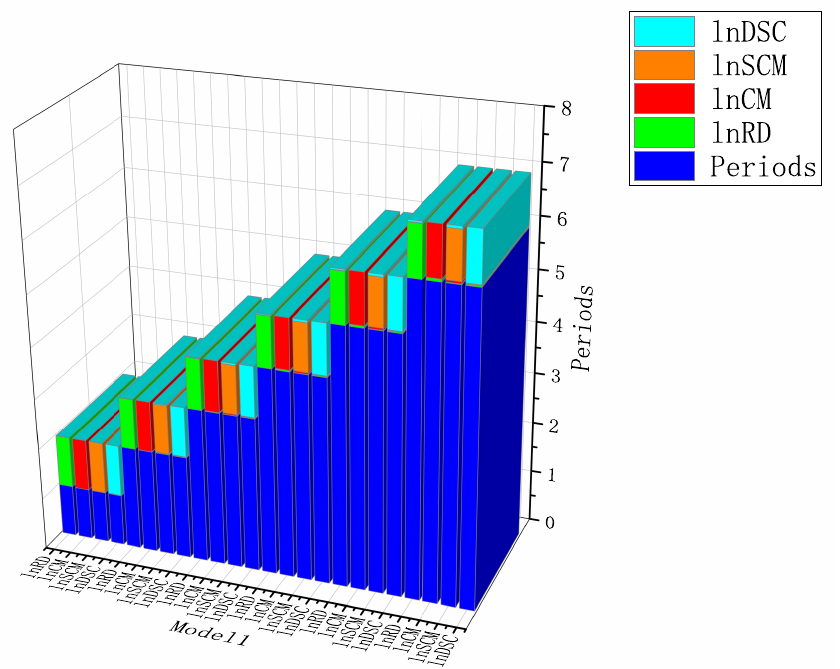
Figure 12. The graph shows the results of the variance decomposition of model 1. The horizontal axis indicates the different variables, including debt servicing capacity (lnDSC) (in light blue), supply chain management (lnSCM) (in orange), corporate management (lnCM) (in red) and R&D innovation (lnR&D) (in green), and the vertical axis indicates the contribution of each variable at different lags (see Appendix A for specific figures), and the blue area indicates the number of periods